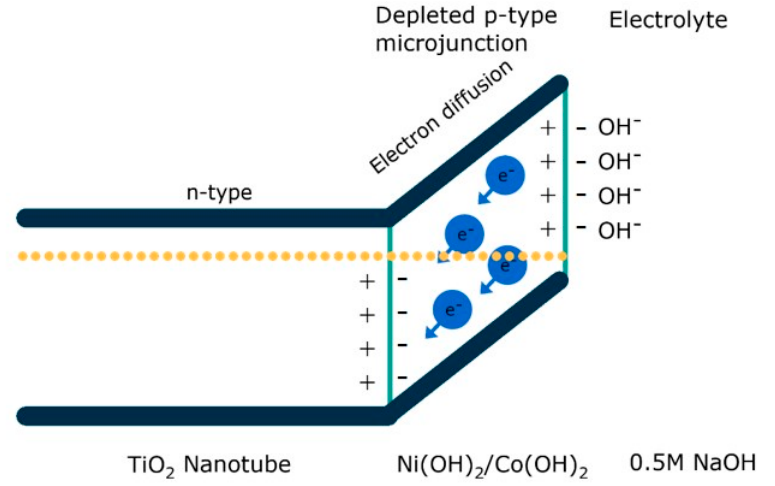
Figure 14. Schematic representation of the p-n microjunction facilitating the oxygen evolution reaction in electrodes containing nickel and cobalt oxides.